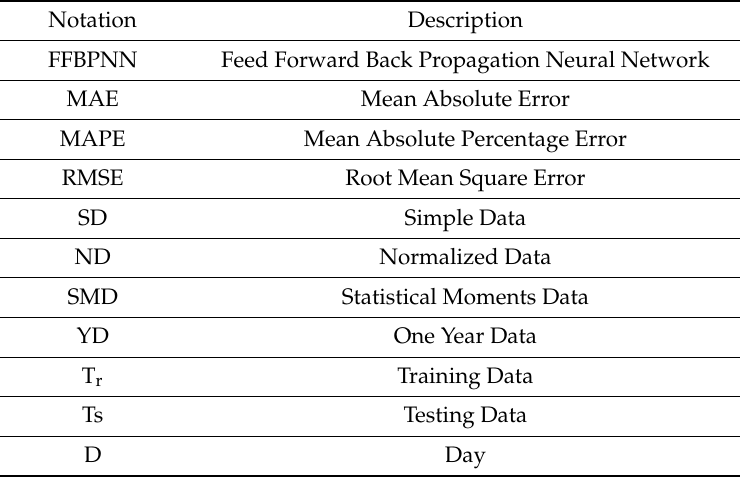
Table A1. Description of abbreviations/notations used in the